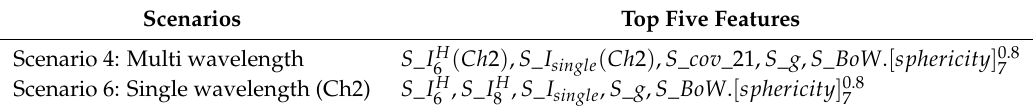
Table 8. List of the top five features for two classification scenarios 4 and 6 (each scenario is defined in Table 5). Each scenario has 30 features selected via the feature selection step. The below mentioned feature abbreviations are explained in Section